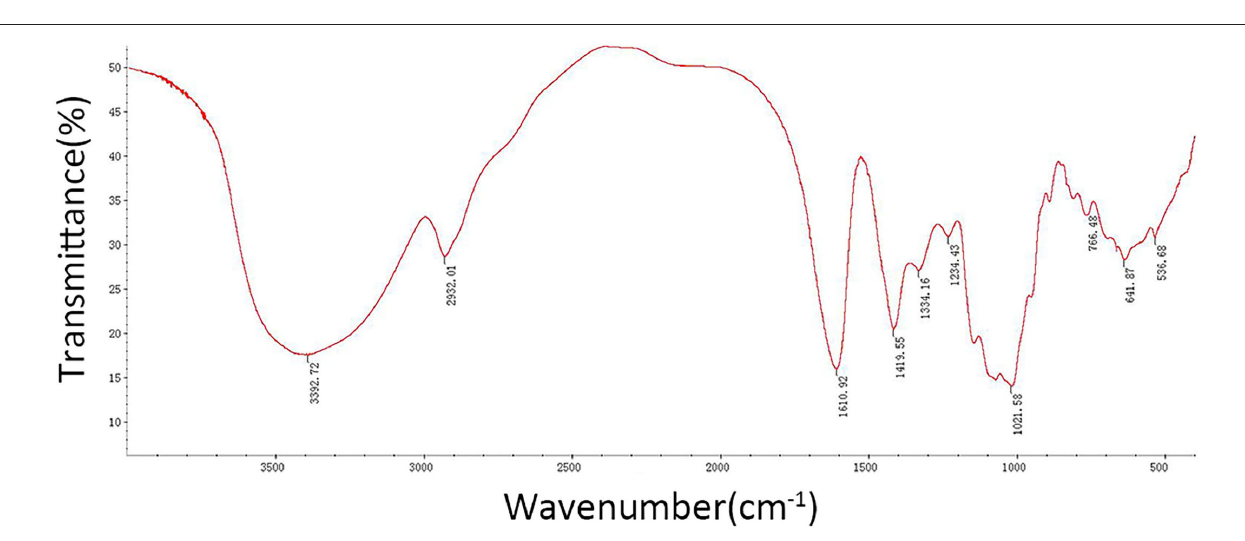
FIGURE 3 | FT-IR spectra of